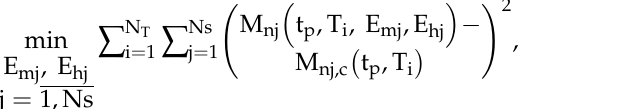
Figure 4. Dependence of the calculated average molecular weight of PP on the temperature T and the polymerization duration t p , calculated using the polycenteric model using the activation energies from Table 3 (polymerization conditions in Table 2).